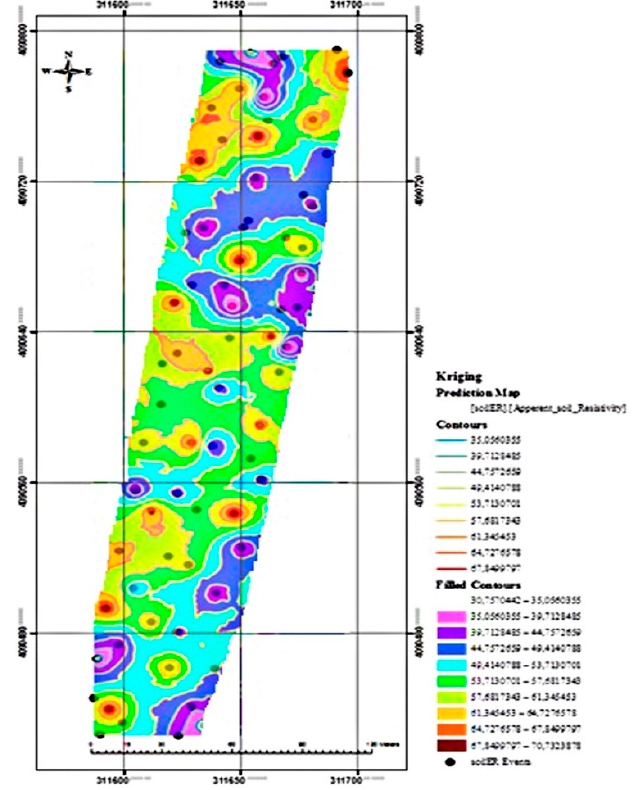
Figure 10. The interpolation map of the soil ER.